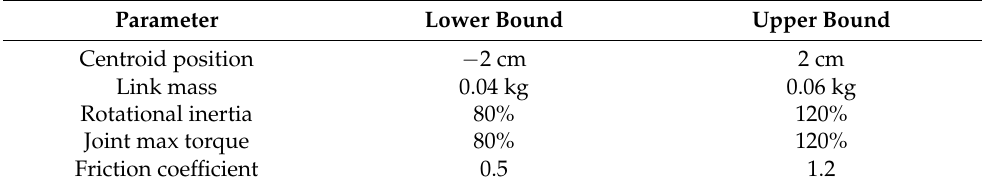
Table 3. Parameter disturbance range of VkHex model.